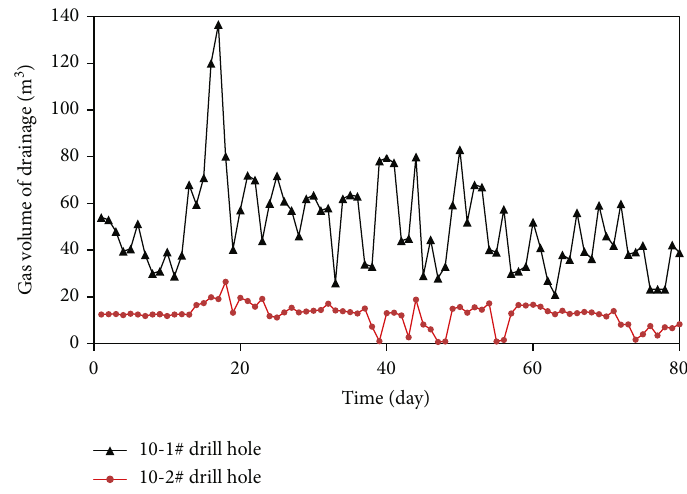
Figure 15: Gas extraction in the borehole group